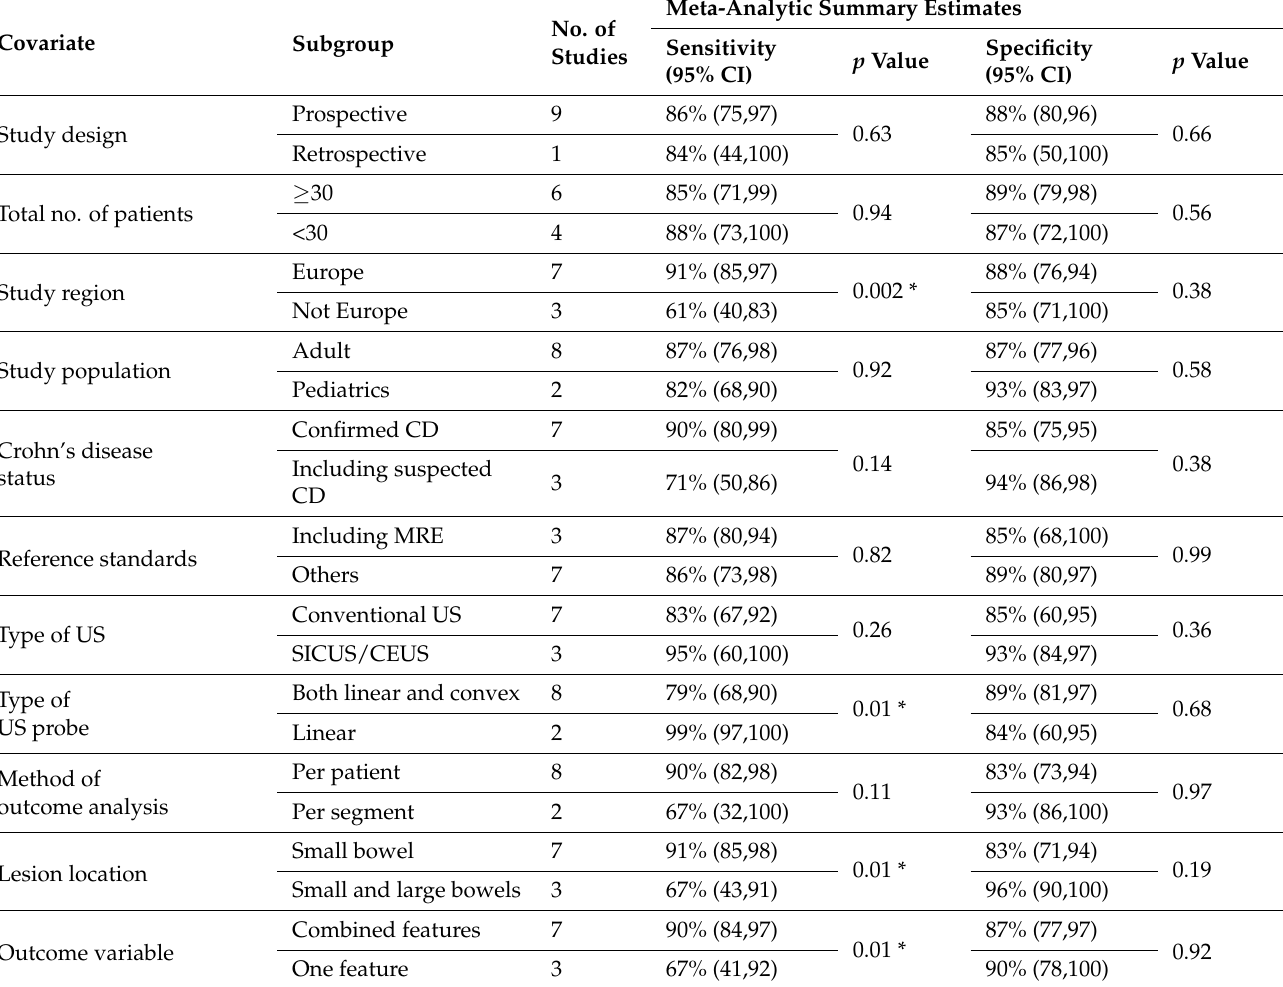
Table 3. Meta-regression analysis of the diagnostic performance of US in diagnosing active bowel lesions in patients with Crohn’s